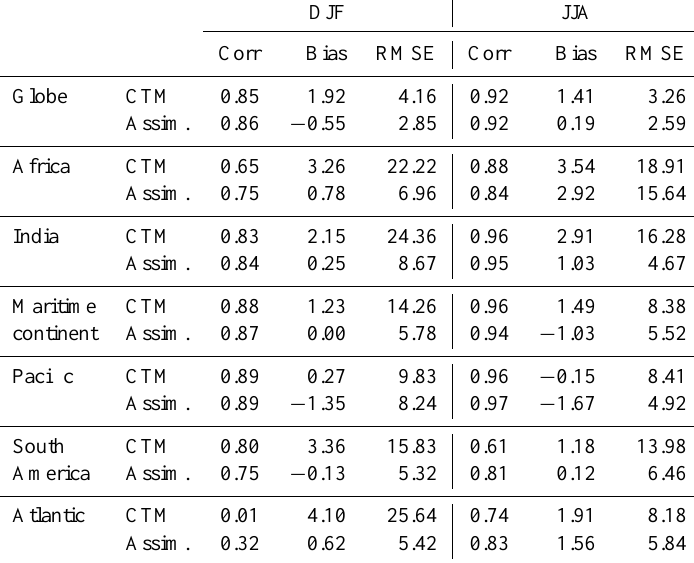
Table 5. The spatial correlation (corr), mean difference (bias), and mean root-mean-square error (RMSE) of the three-monthly mean tropo- spheric O 3 columns (TOCs) for the OMI/MLS data of December–February (DJF) and June–August (JJA) in 2007. The results of the CTM simulation and data assimilation are shown for the latitude band 30 ◦ S–30 ◦ N for the globe (180 ◦ W–180 ◦ E), Africa (15 ◦ W–50 ◦ E),